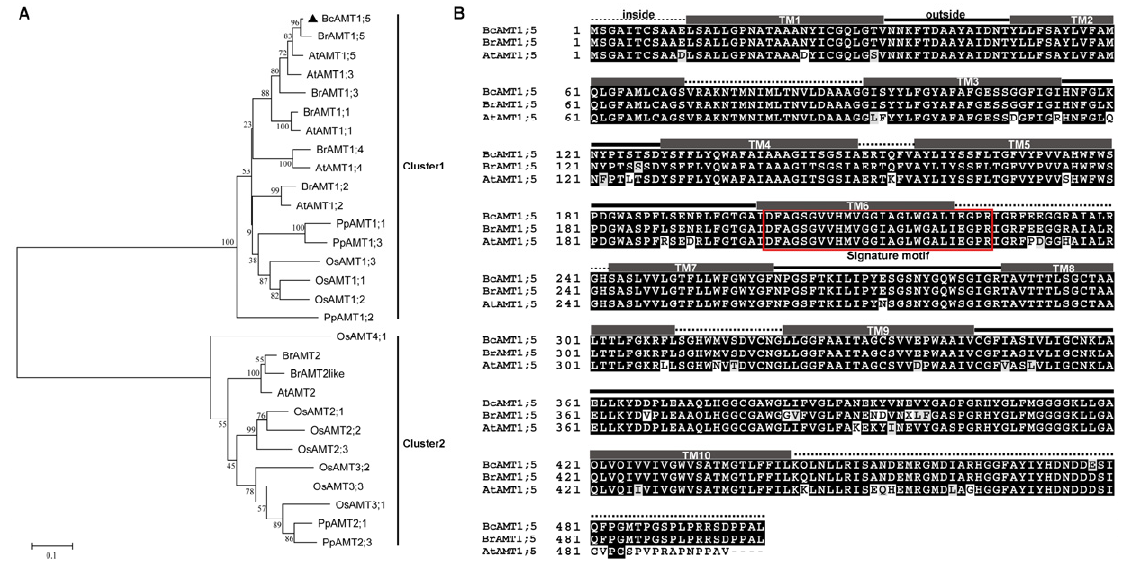
Figure 1. Phylogenetic tree of ammonium transporter (AMT) homologs and the alignment of AMT1;5 amino acid sequences from Brassica campestris , B. rapa , and Arabidopsis . ( A ) The phylogenetic tree of AMT family proteins was constructed using MEGA 6.0. The numbers at the nodes are bootstrap values. At, Arabidopsis thaliana ; Bc, Brassica campestris ; Br, Brassica rapa ; Os, Oryza sativa ; Ptr, Populus trichocarpa . BcAMT1;5 from B. campestris is marked by a black triangle. The sequence information for each AMT protein is provided in Table S2. ( B ) Sequence alignment of BcAMT1;5, BrAMT1;5, and AtAMT1;5 performed by using Clustalw in MEGA 6.0. Single-letter designations and white letters on black present different amino acids residues and identical residues at the aligned positions of two or three sequences, respectively. Transmembrane domains (TMs) of AMTs were predicted by Protter (http://wlab.ethz.ch/protter/). Gray boxes above the sequences show 10 potential TMs positions, the dotted line and solid line show putative inside- and outside-cytoplasm domains, respectively. The sequences marked in the red box represent the signature motif identified by Couturier et al. [23] for the AMT1